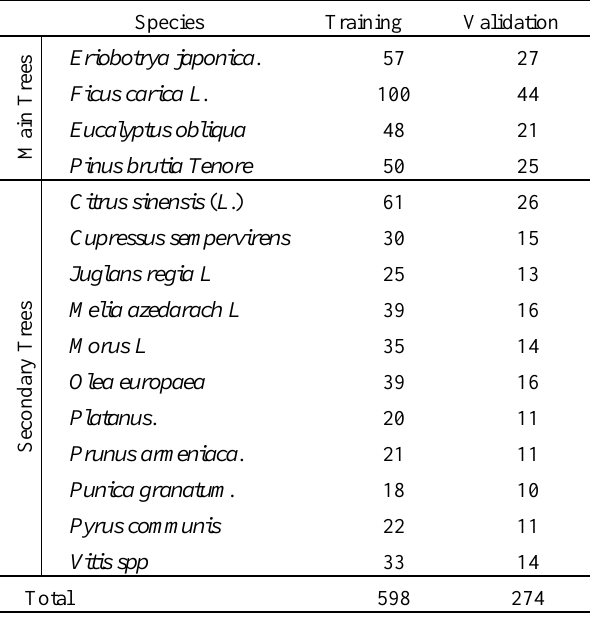
Table 1: A list of fifteen (main and secondary) tree species used in this study, split into training and validation samples.